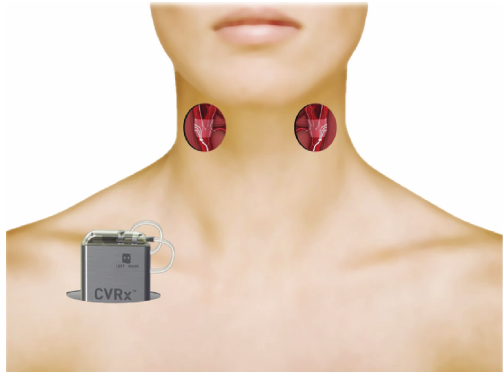
Figure 1: Schematic representation of the Rheos device for carotid baroreceptor